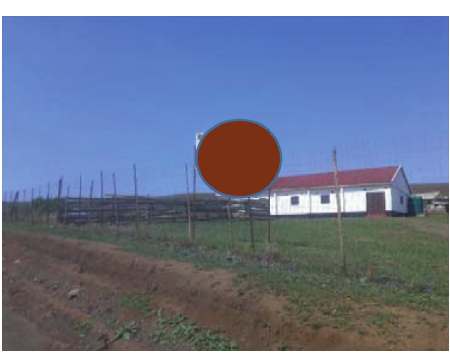
Figure 8: Church: site two.